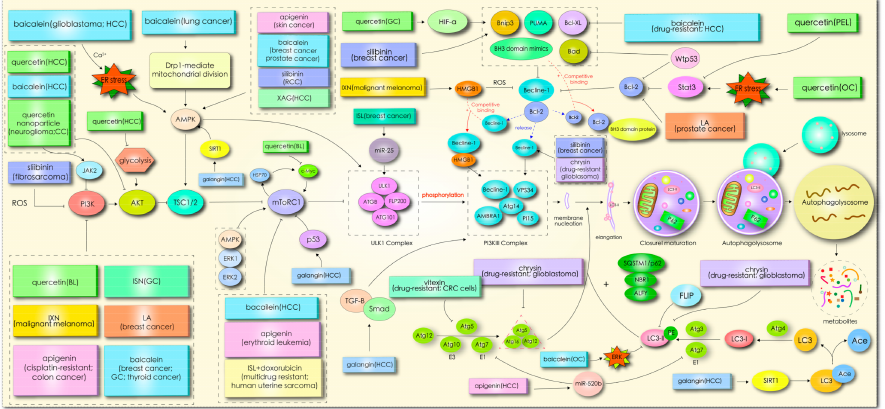
Figure 2. Mechanism through which flavonoids induce cancer cell autophagy. Many autophagic regulators may determine the process of autophagy. Phosphoinositide 3-kinase (PI3K)/protein kinase B (AKT) can stimulate the mammalian target of rapamycin (mTOR), which is negatively regulated by mitogen-activated protein kinase (MAPK), to suppress activation of the unc-51-like kinase (ULK)1/2 complex. Additionally, MAPK can be directly activated by the ULK1/2 complex in an independent mTOR manner. Subsequently, the ULK1/2 complex triggers membrane nucleation by phosphorylating the PI3K III complex, including phosphorylation beclin-1, activation AMBRA1, Atg14, and p115. The PI3K III complex recruits two interrelated ubiquitin-like protein (UBL) binding systems (the Atg12-Atg5-Atg16 system and LC3 system) to regulate membrane elongation and autophagosome expansion. Damaged proteins and organelles are brought into the autophagosome through the LC3 complex containing p62/SQSTM1. If the damaged protein is not transported to the autophagosome, p62/SQSTM1 accumulates in the cell, exacerbating endoplasmic reticulum stress. mTOR, as an important target for autophagy, is targeted by several tumor regulators, such as TSC1/2, PTEN, JAK2, silent information regulator 2 homolog 1 (SIRT1), AMP-activated protein kinase (AMPK), p53, and reactive oxygen species (ROS). In particular, heat shock proteins (HSPs) can stabilize proto-oncogene c-Myc activation, upregulating mTOR expression and promoting cell